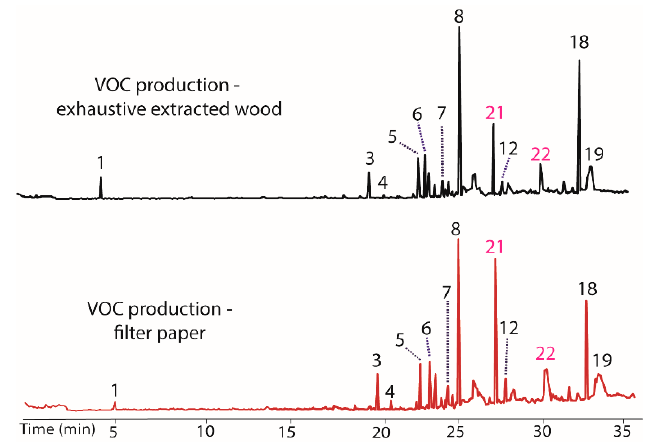
Figure 6. Chromatograms illustrating the changes in the production of VOCs by BS15 following exposure to filter paper ( bottom ) and to exhaustively extracted woody tissue from branches of T. distichum ( top ).